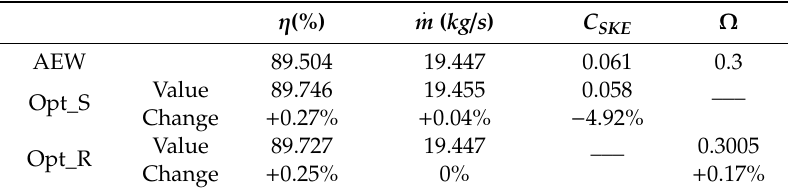
Table 1. Summary of optimization